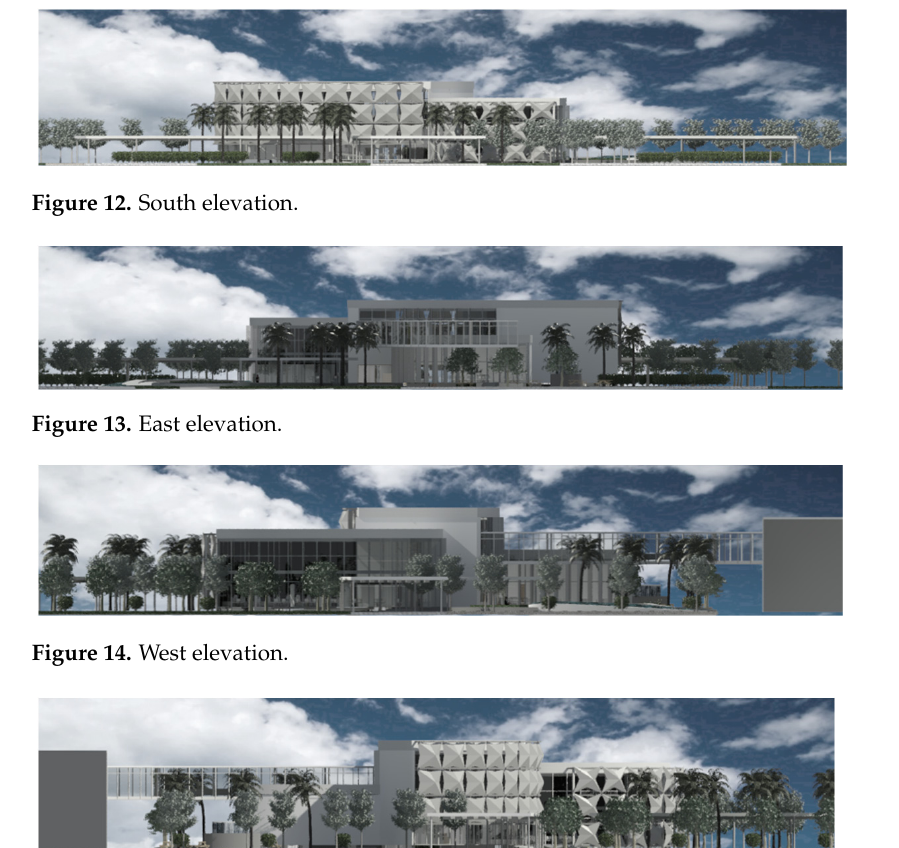
Figure 11. 3D rendered eye bird Views ( a ) south view, ( b ) north view.